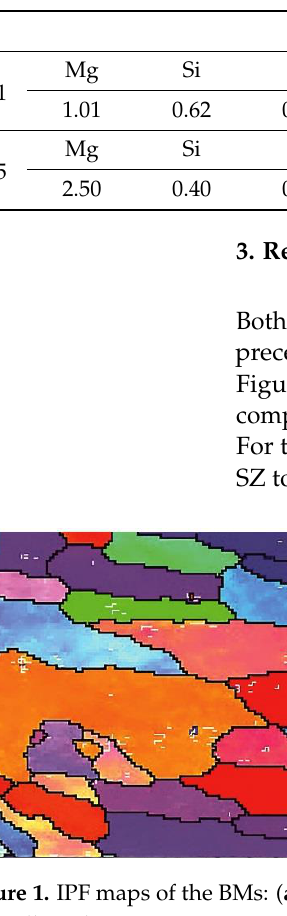
Figure 2. ( a ) Cross-sectional macrostructure of the joint. ( b – d ) the microstructures of the areas identified in ( a ): ( b ) grain subdivision in TMAZ of AA6061 (the inset image in left-bottom corner is an enlarged view of the area identified by white rectangle); ( c ) elongated large grains in TMAZ of AA7075 without subdivision process; ( d ) the interfacial area at the center of the joint. White rectangles (1-3 numbered) refer to the EBSD scan areas. The white line belongs to the hardness meas- urement line. The white arrow refers to a void formed in the cross-section of the joint. The IPF and grain boundary maps of TMAZ and the transition zone (to SZ) in the AA6061 side are shown in Figure 3a,b. Figure 4 illustrates the IPF map of the interfacial area in the SZ, which indicates two different grain sizes in a dissimilar joint of Al alloys under the same deformation condition. The hardness profile along with the correspond- ing indentation plan in the middle line on the cross-section of the joint are presented in Figure 5. Furthermore, to characterize the variation of the hardness values across the joint and to correlate with the corresponding microstructures, some OM images were taken from specific locations (identified by a – f in the hardness profile), which are shown in Fig- ure 6.